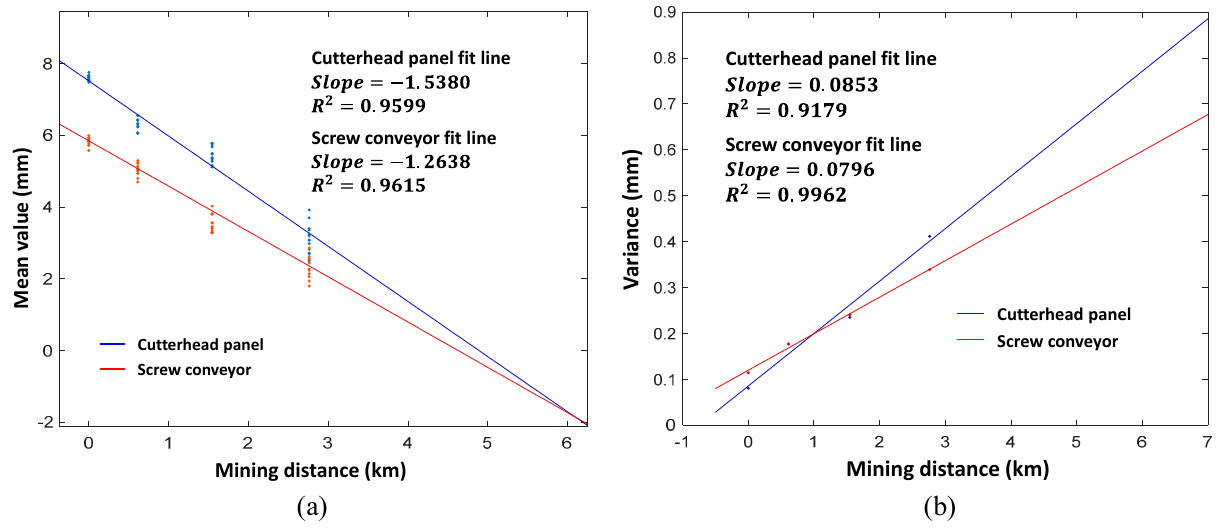
Figure 5. Fitted regression lines of the cutter head and screw conveyor at different mining distances: ( a ) mean values; ( b ) variance values.